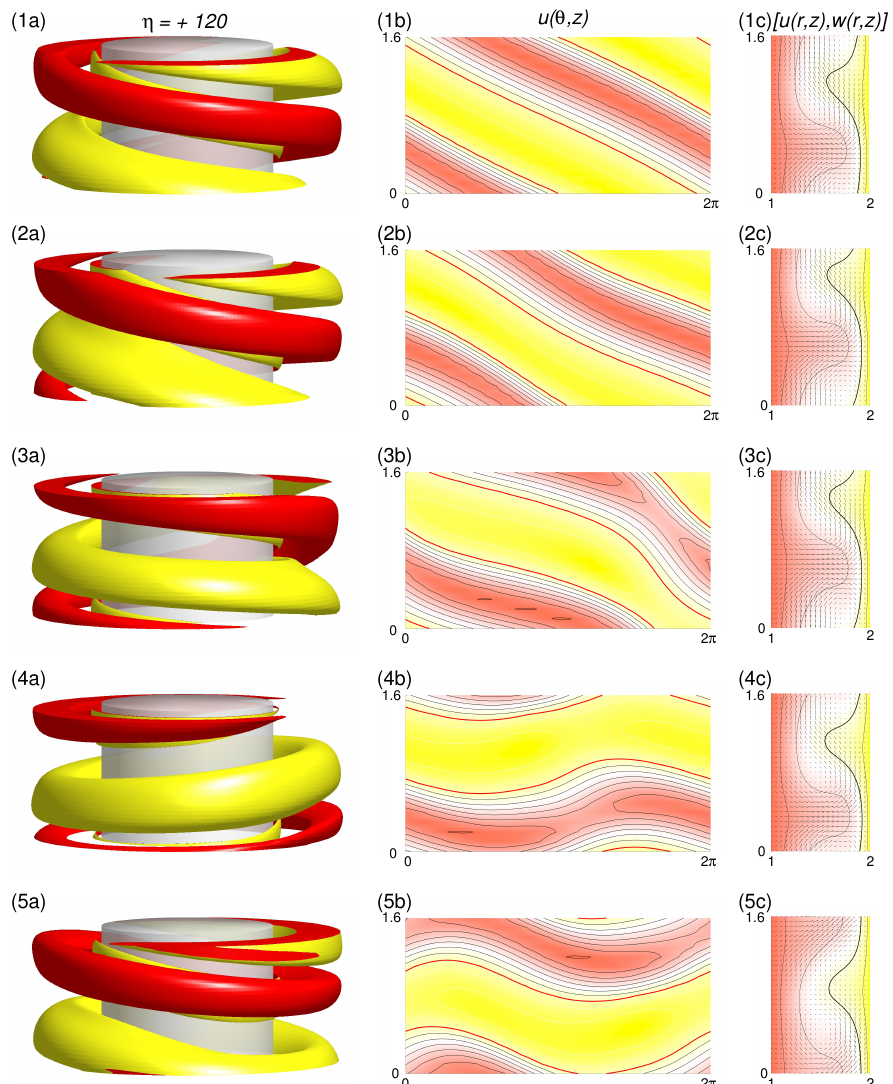
Figure 12. Flow visualization of various flow pattern appearing within the transition scenario between the two unstable solutions 1-mwTVF and L1-wSPI, respectively. Snapshots ( 1 )–( 5 ) for times indicated (A)–(E) in Figure 11a. Shown are ( a ) isosurfaces of η [red (dark gray) and yellow (light gray) colors correspond to positive and negative values, respectively.] ( b ) the radial velocity u ( θ , z ) on an unrolled cylindrical surface in the annulus at mid-gap [red (yellow) color indicates in (out) flow with zero specified as white], ( b , c ) vector plot [ u ( r , z ) , w ( r , z )] of the radial and axial velocity components (including the color-coded azimuthal velocity v . The thick contour lines in ( c ) correspond to v =